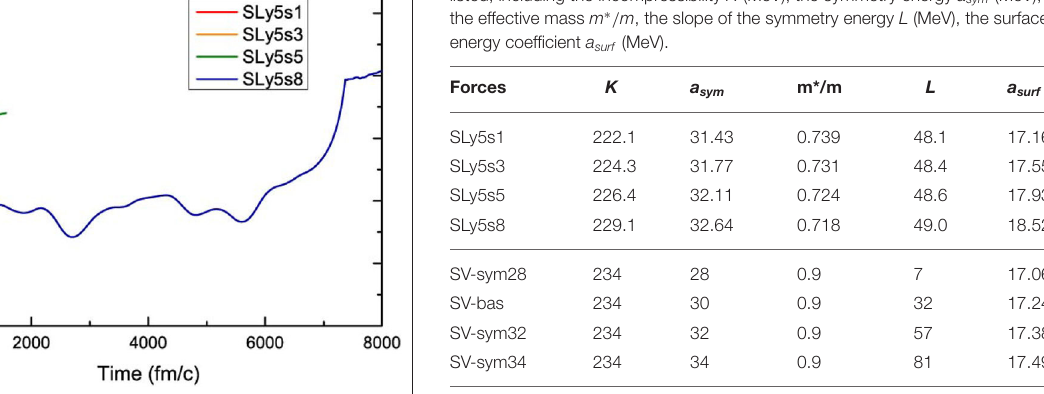
FIGURE 2 | The evolutions of quadrupole deformations in TDHF calculations with the SLy5s1, SLy5s3, SLy5s5, SLy5s8 forces.